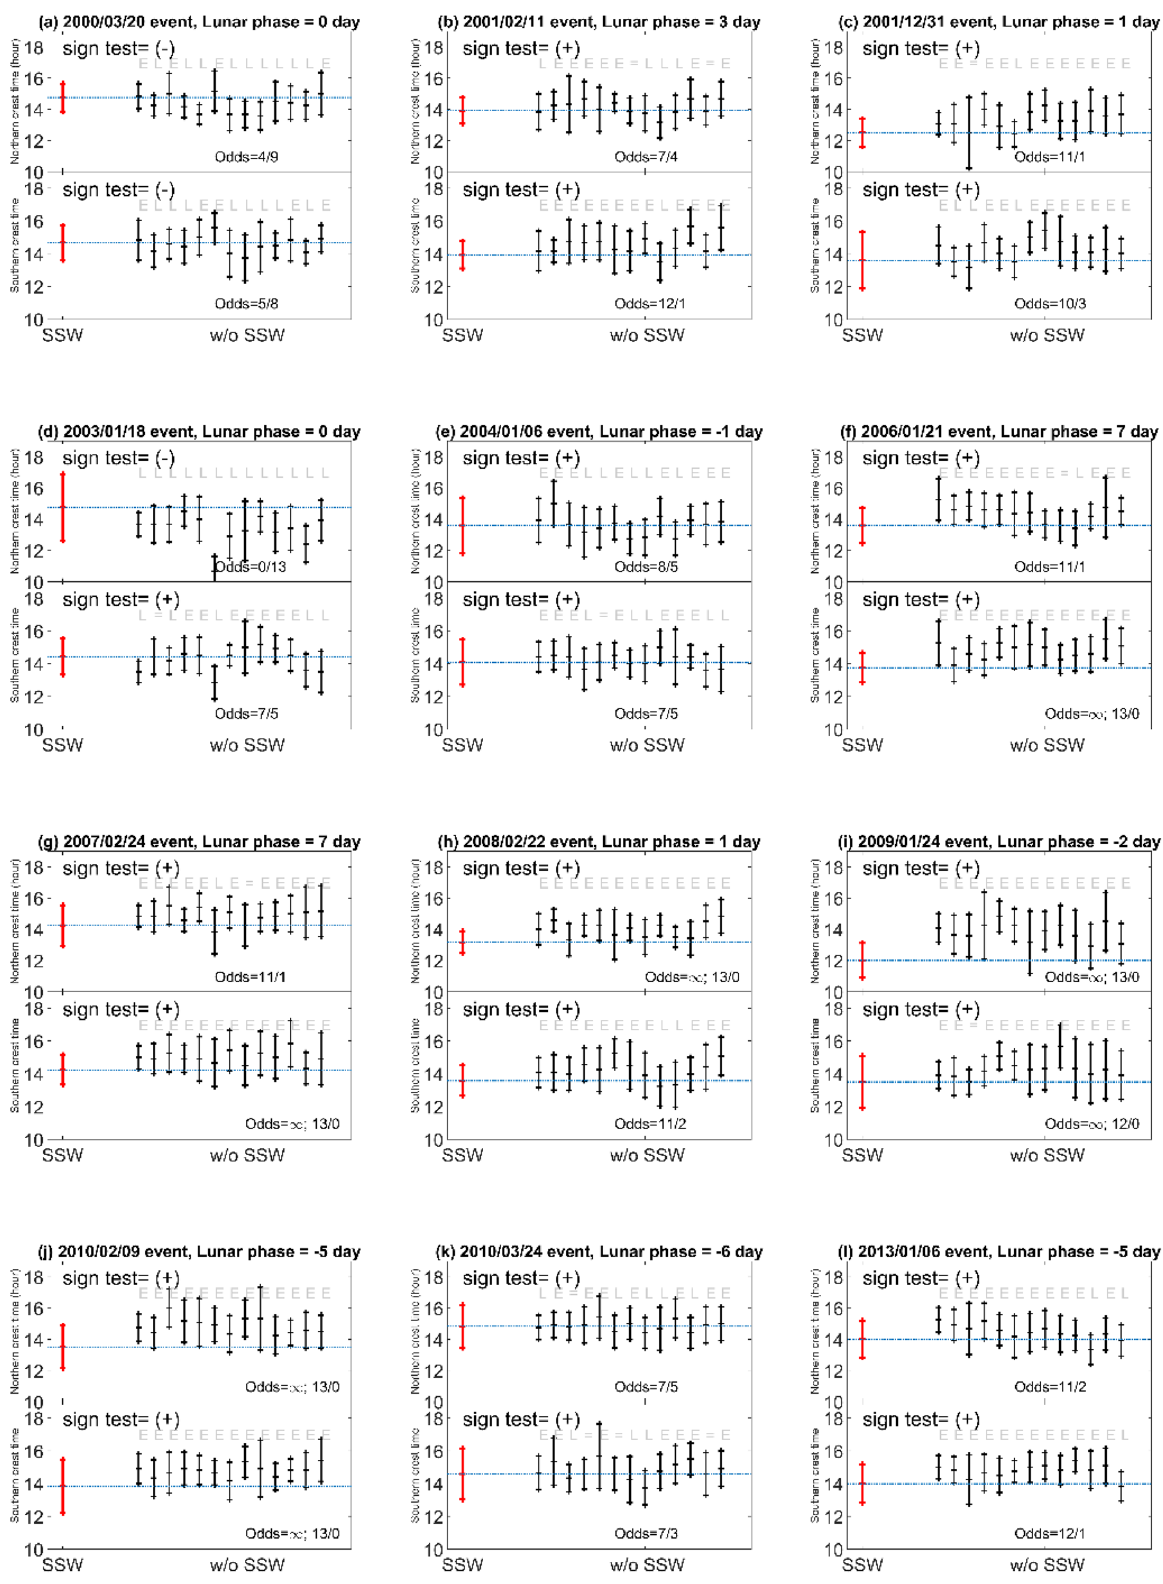
Figure 5. The EIA crest appearance times on day with and without SSW events. The EIA crest appearance times of the 24 longitudes on the SSW event day (red segment) and associated references lunar day without (w/o) SSW in the other 13 years (black segments) in the both hemispheres. Each segment consists of 24 data points in the 24 longitudes of the globe. Two end ticks of the segment stand for one standard deviation, while the center tick denotes the mean. E and L indicate the mean of the EIA crest appearance time of the event being earlier and later than the associated reference mean, respectively. If it’s a tie, a sign of “ = ” is denoted. When tie, it will not be included the ratio